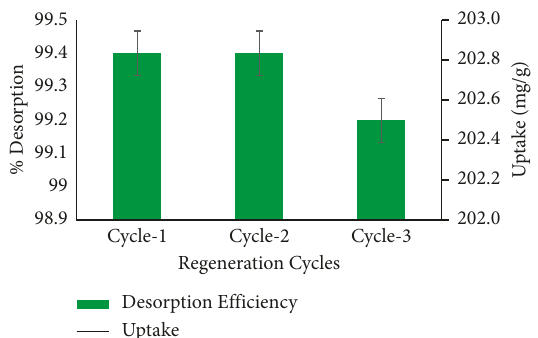
Figure 10: Desorption efficiency of RO16 for varying regeneration